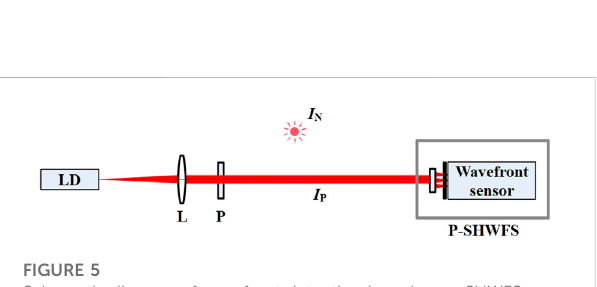
FIGURE 5 Schematic diagram of wavefront detection based on p-SHWFS. L: Lens; Pr: Polarizor; LD: Laser diode. I N : strong stray